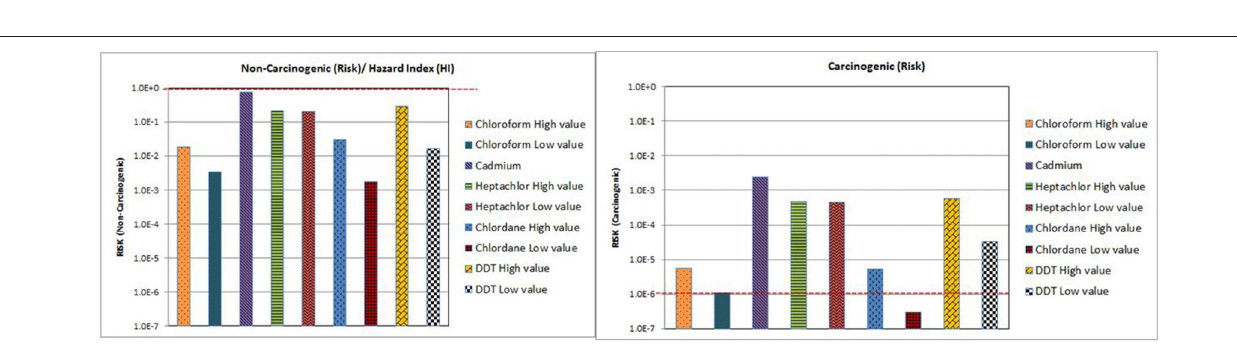
do no cause bio-magnification, and (d) the pollutant has to be biologically active to cause